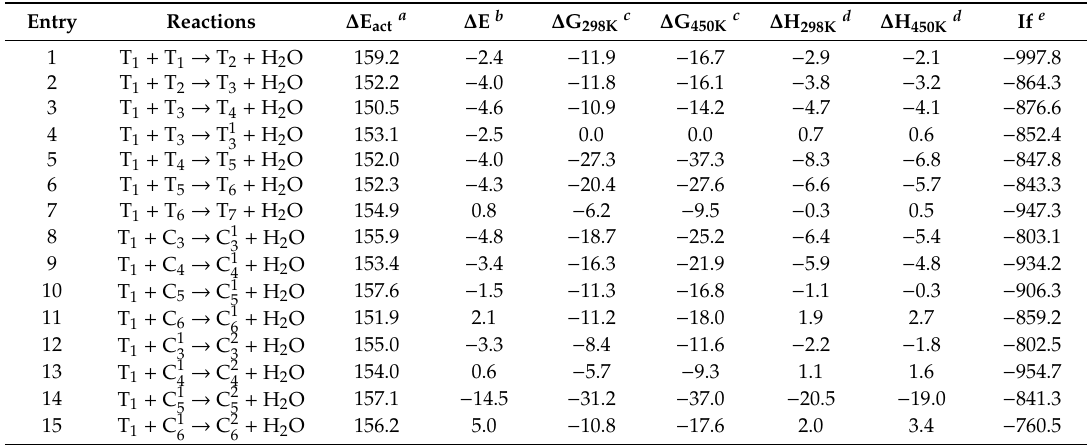
Table 3. Energy profile (kJ / mol) for the formation of linear oligomers through the MAM mechanism. Entry